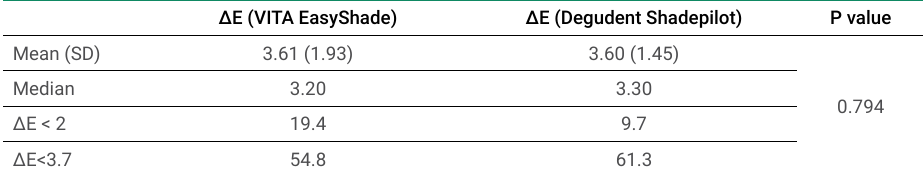
Table 2. Means (Standard Deviations) and medians of the calculated E values with both devices with E Cut-off values of 2.0 and